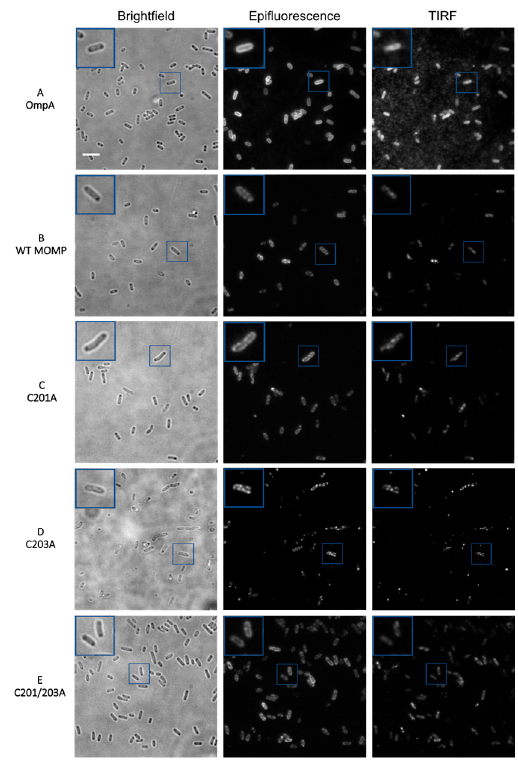
Figure 2. Brightfield, epifluorescence and total internal reflection fluorescence (TIRF) microscopy images of rMOMP cysteine mutants in C41 (DE3) E. coli cells. ( A ) E. coli anti ‐ OmpA; ( B ) wild ‐ type rMOMP; ( C ) rMOMP C201A; ( D ) rMOMP C203A; ( E ) rMOMP C201/3A. rMOMP ‐ expressing cells were stained using anti ‐ His rabbit primary antibody coupled with anti ‐ rabbit Alexa Fluor 488 secondary antibody, with control E. coli cells stained using anti ‐ OmpA rabbit primary antibody coupled with anti ‐ rabbit Alexa Fluor 488 secondary antibody. Scale bar is 5 μ m, inset is ×2 magnification.